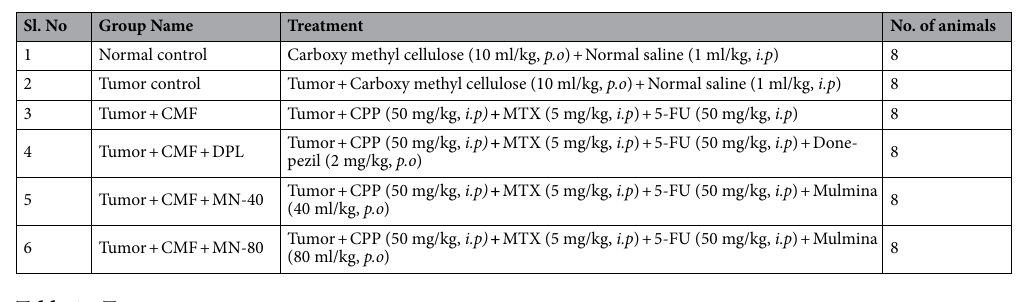
Table 1. Treatment